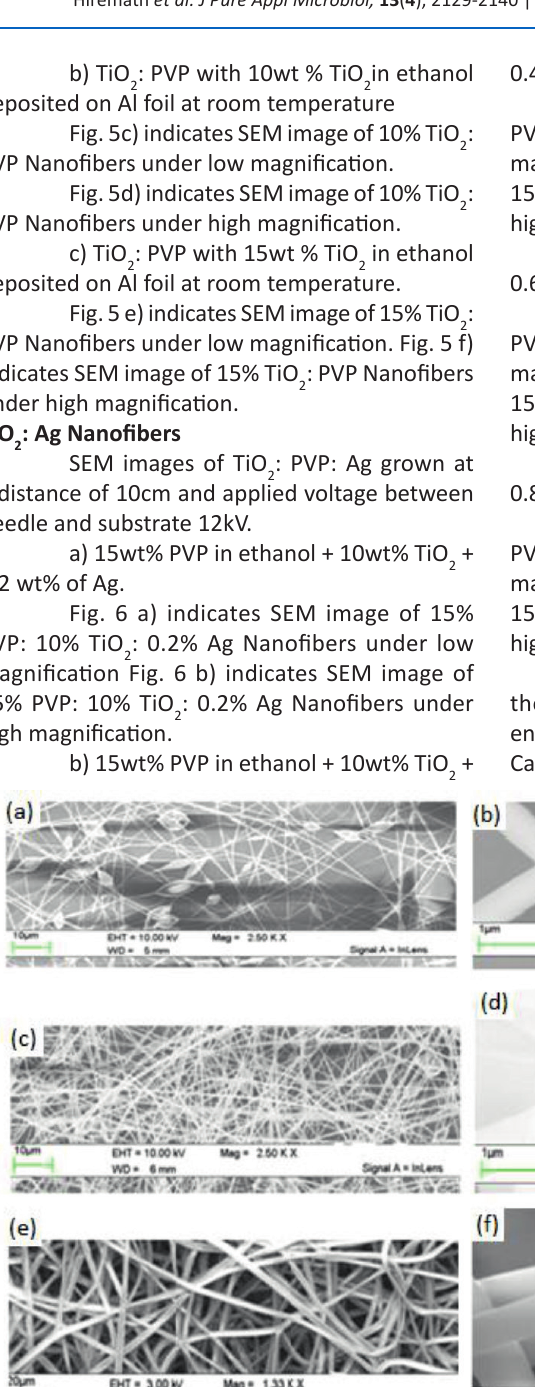
: PVP Nanofibers: a) Low Magnification (5% TiO Fig. 5. SEM image of TiO 2 Magnification (10% TiO ) d) High Magnification (10% TiO 2 (15% TiO 2